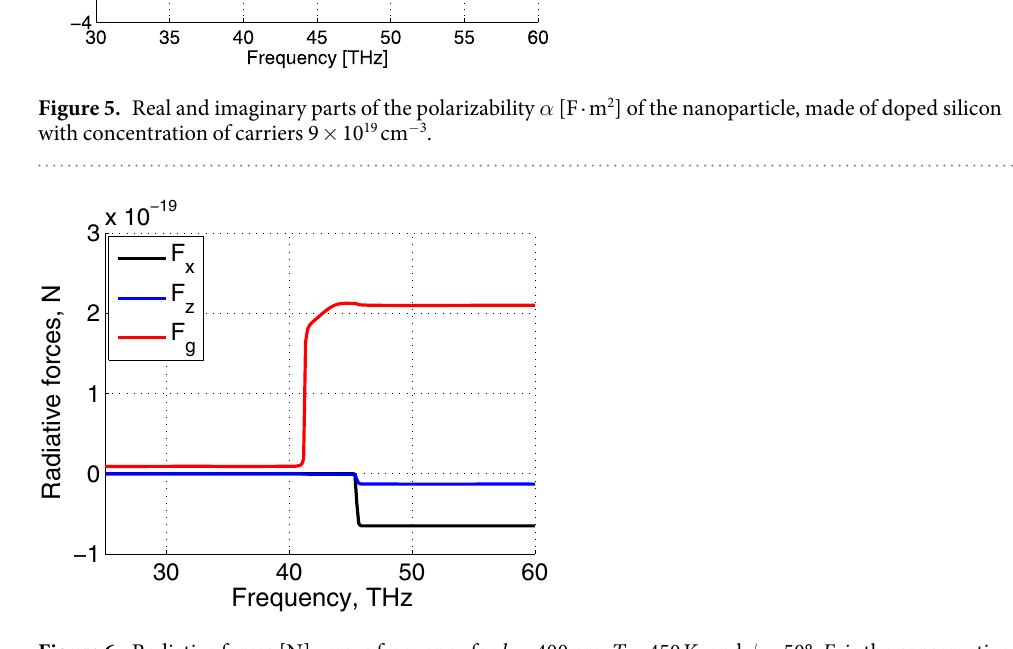
Figure 6. Radiative forces [N] versus frequency for h = 400 nm, T = 450 K, and φ = 50°: F g is the conservative, attractive gradient force, exerted by non-homogeneous fields of evanescent waves (red); F x (black) and F z (blue) are the lateral and normal repulsive, non-conservative forces, induced by the corresponding components of the Poynting vector,